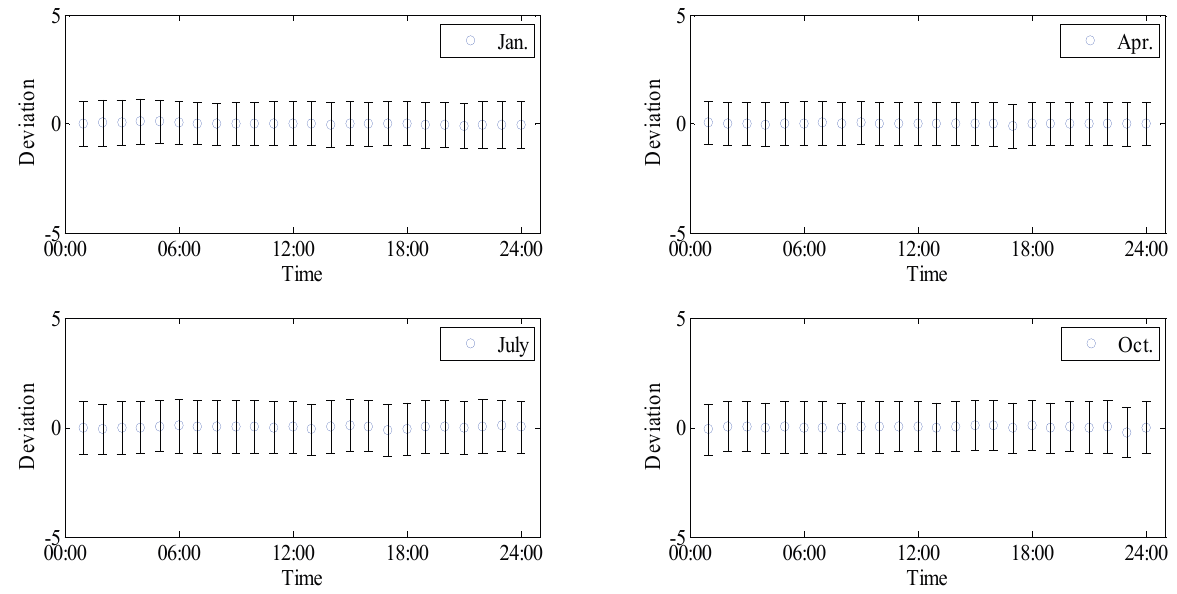
Figure 7. Monthly averaged deviations of hourly mean CO means at Zhongshan Station in January, April, July and October. The mole fraction is averaged over 2011–2012. Vertical bars represent the standard deviations.